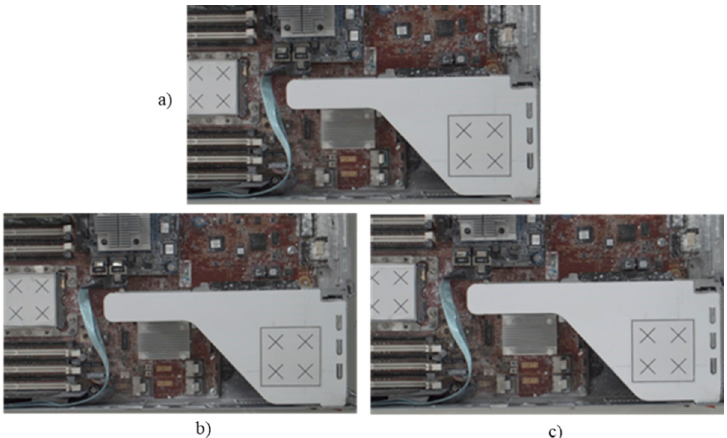
Figure 18. Position correction system test results for two random positions. Standard image without displacement or rotation shown in ( a ) Figure 14c, and new images after ( b ) the first random position shown in Figure 15a and ( c ) the second random position shown in Figure 15b.